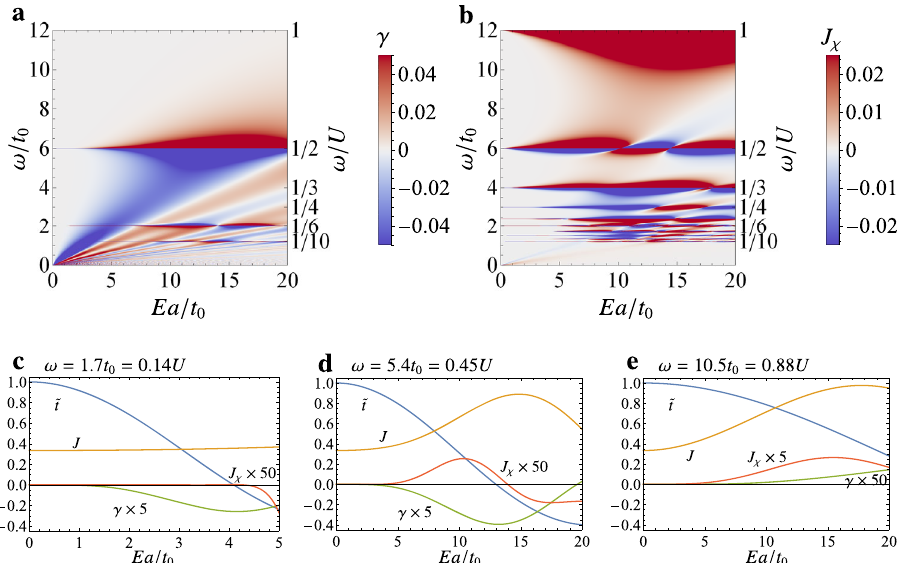
Fig. 3 Dependence of the coupling constants on the laser intensity for the driven model. a , b Two-step correlated hopping γ ( a ), and scalar spin-chirality term J χ ( b ) are colour-coded against circularly-polarised-light amplitude E and driving frequency ω . Figure 1d corresponds to a cross section of b at E = 6 t 0 / a . c – e The renormalised hopping amplitude ~ t , exchange coupling J , along with the two-step correlated hopping γ [Eq. (18)] and the chiral spin-coupling J χ [Eq. (19)], against E . The driving frequency is chosen as ω = 1.7 t = 0.14 U ( c ), ω = 5.4 t = 0.45 U ( d ), or ω = 10.5 t = 0.88 U ( e ) with t 0 0 0 0 : bare hopping amplitude, a : lattice constant. Note a difference in the horizontal scale between ( c ) and ( d , e ). We take here the bare second-neighbour hopping t 0 ¼ (cid:3) 0 : 2 t 0 , the onsite interaction U = 12 t 0 , and a doping level δ = 0.2. Here, the in fi nite summations of Fourier components [ ∑ m in Eq. (7) and ∑ lmn in Eq. 0 (39)] are truncated such that the Taylor series up to E 20 is reproduced. This is accurate enough for ω > t 0 , while for the low-frequency regime ω < t 0 an intricate resonant structure due to the ω = U /integer resonance (seen also for t 0 < ω < 4 t 0 ) is not captured.